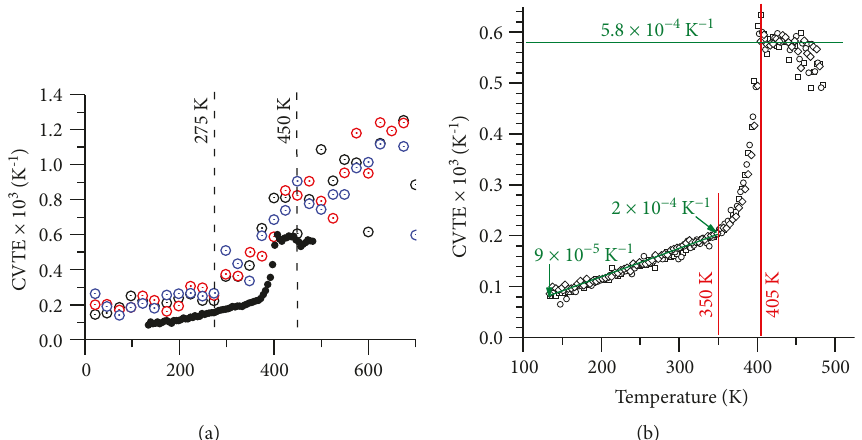
Figure 7: Coe ffi cients of volumetric thermal expansion (CVTE) as a function of temperature for 3 di ff erent initial mixtures (empty circles) and for one TMA cycle (full circles) (a). Zoom on the TMA experimental results